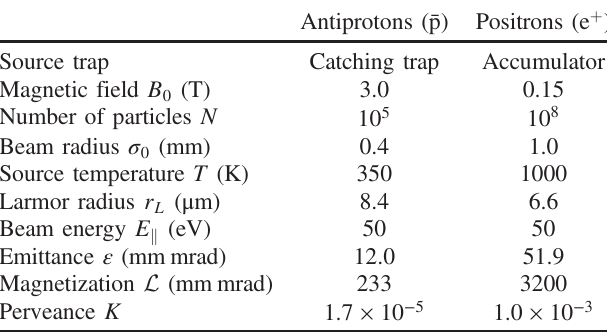
TABLE I. Example characteristics of antiproton and positron bunches extracted from the catching trap and positron accumu- lator, respectively. The true bunch characteristics will vary depending on the experimental protocols used to prepare particles for extraction into the